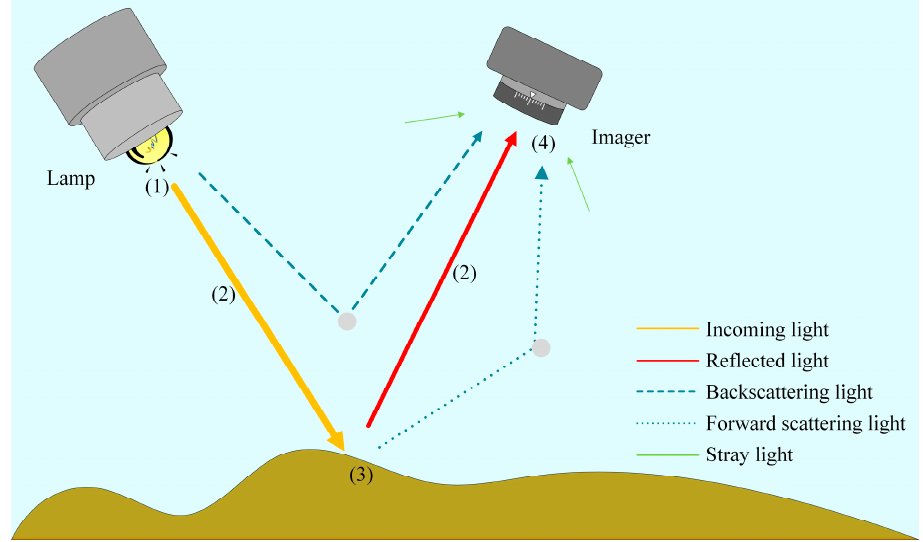
Figure 2. Underwater imaging model: The main processes are ( 1 ) radiation of the light source, ( 2 ) light propagation in the water column, ( 3 ) reflected after incident on the target surface, and ( 4 ) receiving and imaging by the imager.